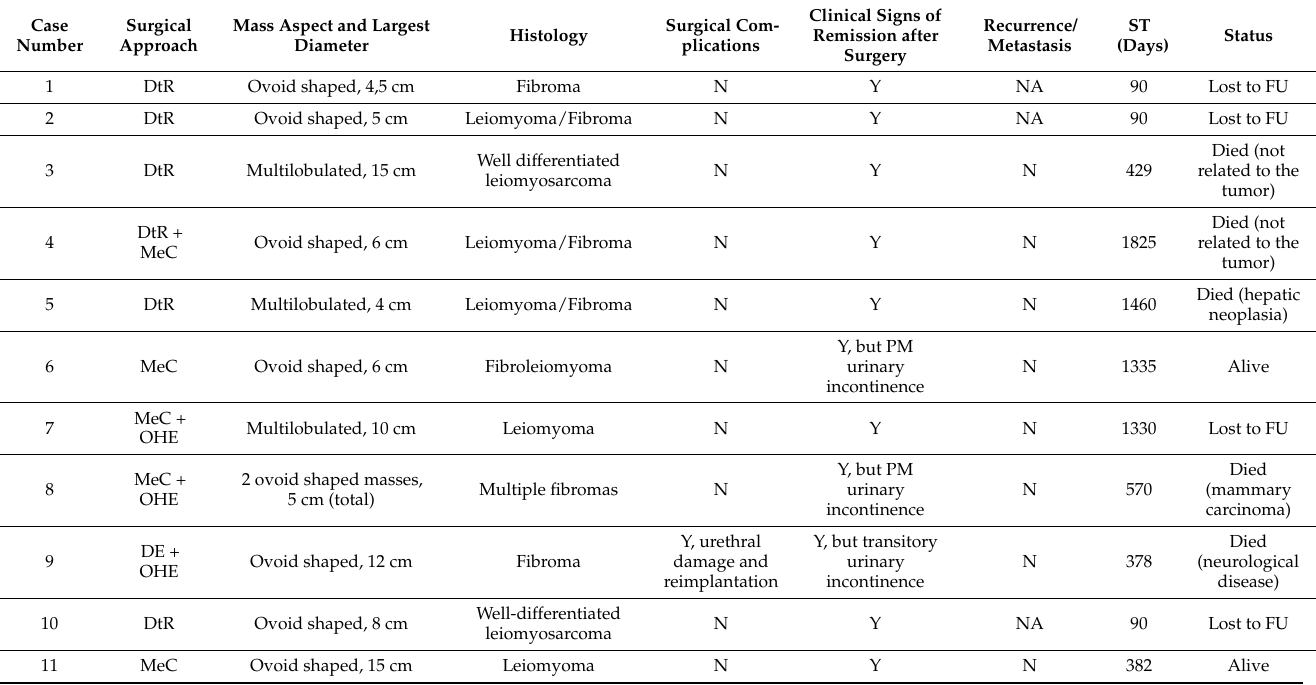
Figure 2. ( A ) Skin incision for the dorsal approach to the rectum. A purse string suture is positioned to occlude the anus. ( B ) Paired rectococcygeus and levator-ani muscles are transected. ( C ) The mass is gradually detached from the surrounding tissues using blunt and digital dissection. ( D ) Postoperative appearance of the perineum after the procedure (purse string removed). Table 2. Aspect and histological features of the mass, the surgical procedures used, the surgical complications observed and